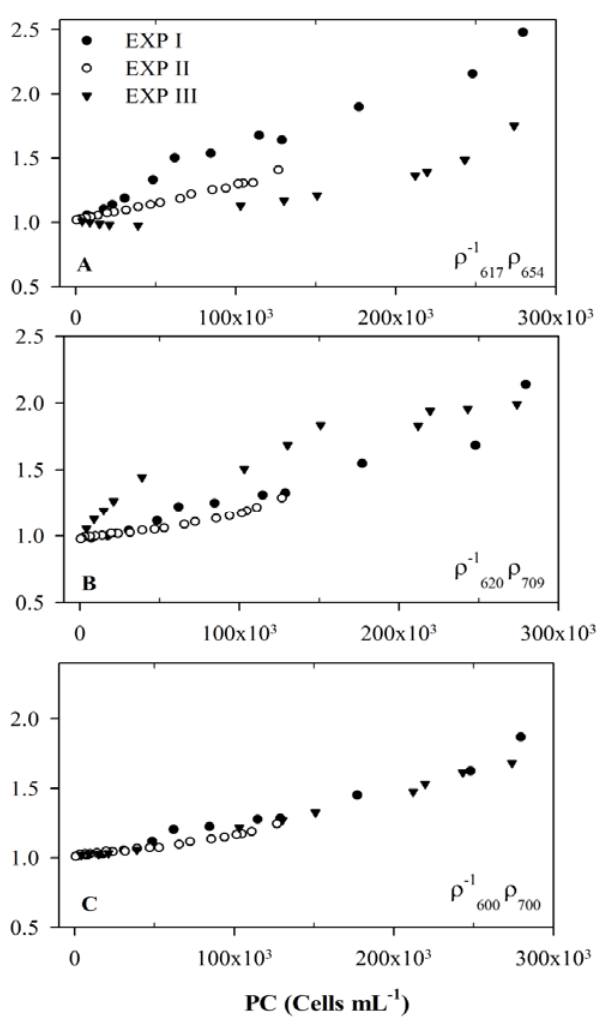
Figure 2. Scatter plots of spectral band ratios such as, A.   7001   , versus measured PC concentration (cells mL − 1 ). Note that the newly developed 600 spectral band ratio (C) has similar trends in all three experiments and outperforms the existing spectral band